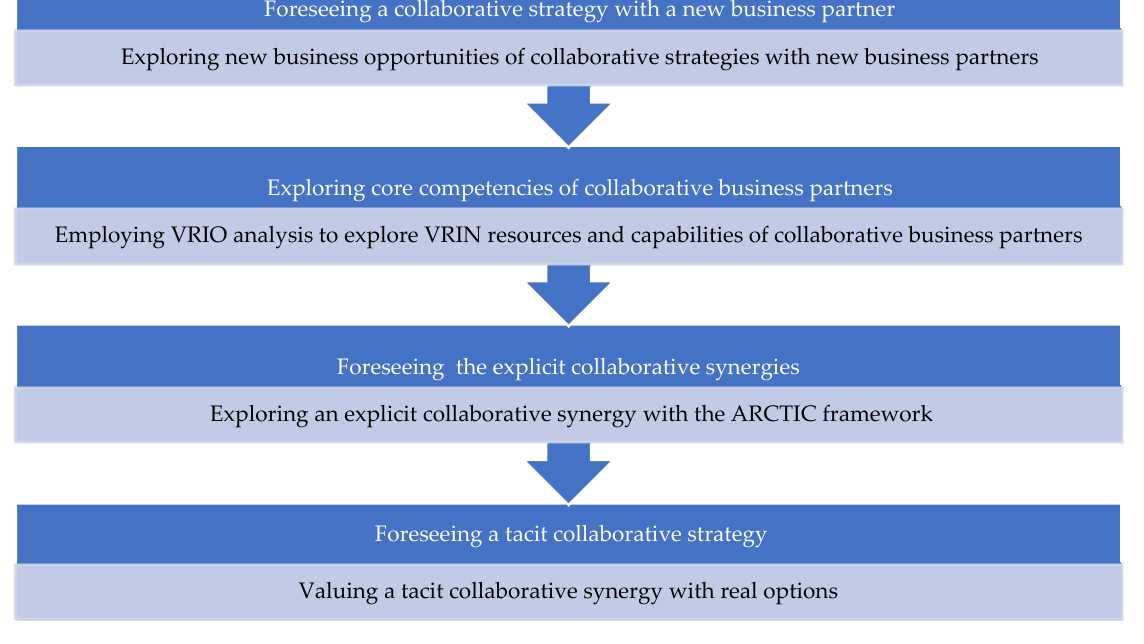
Figure 2. The conceptual construct of research of an explicit and tacit collaborative synergism.